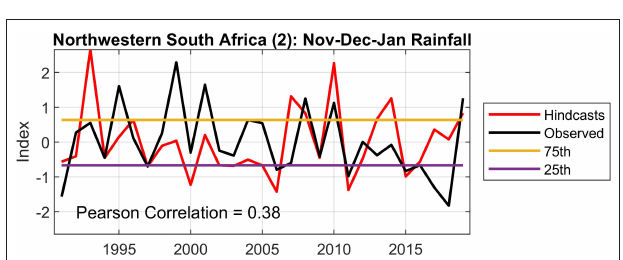
FIGURE 3 | As for Figure 1 , but for the Nov-Dec-Jan rainfall of the second farm located in the northwestern interior of South Africa. The correlation value’s level of confidence is at the 99.7% level.